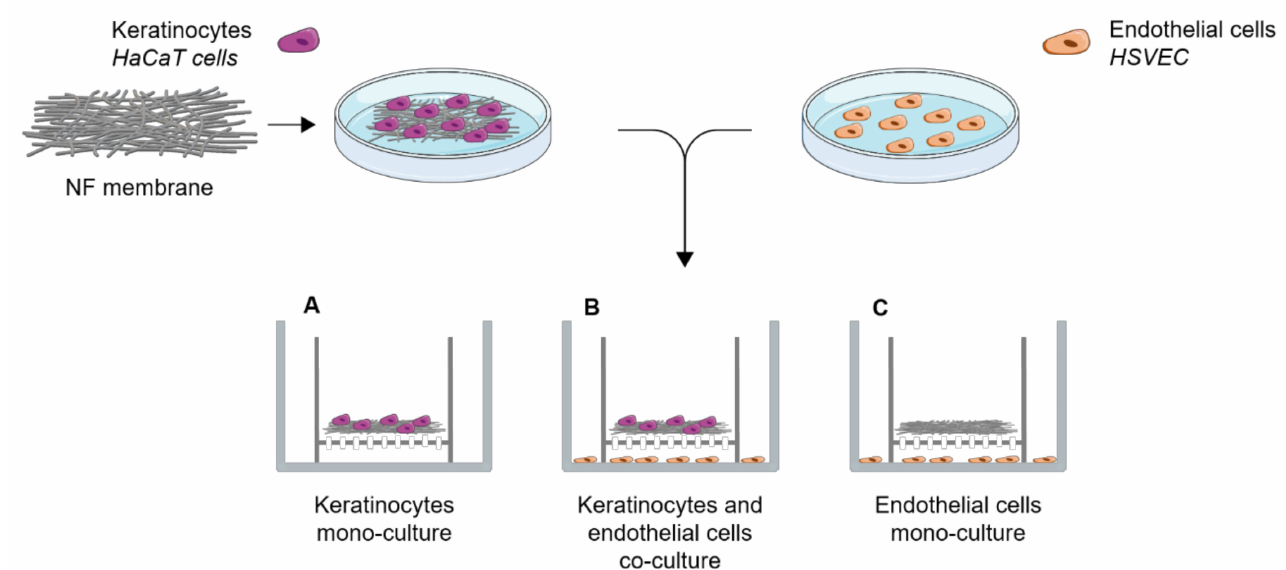
Figure 2. Schematic illustration of the co-culture system used in the experiments with the HaCaT cells and the human saphenous vein endothelial